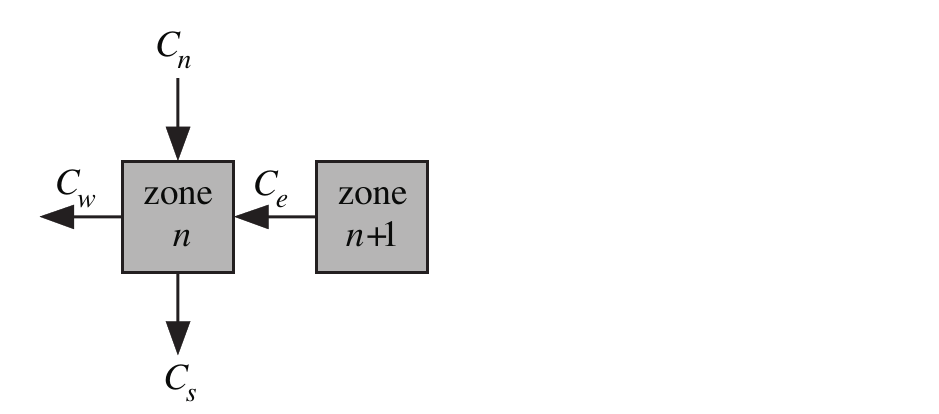
Figure 3. Scheduling time for the case when m = 5 and w = 4.